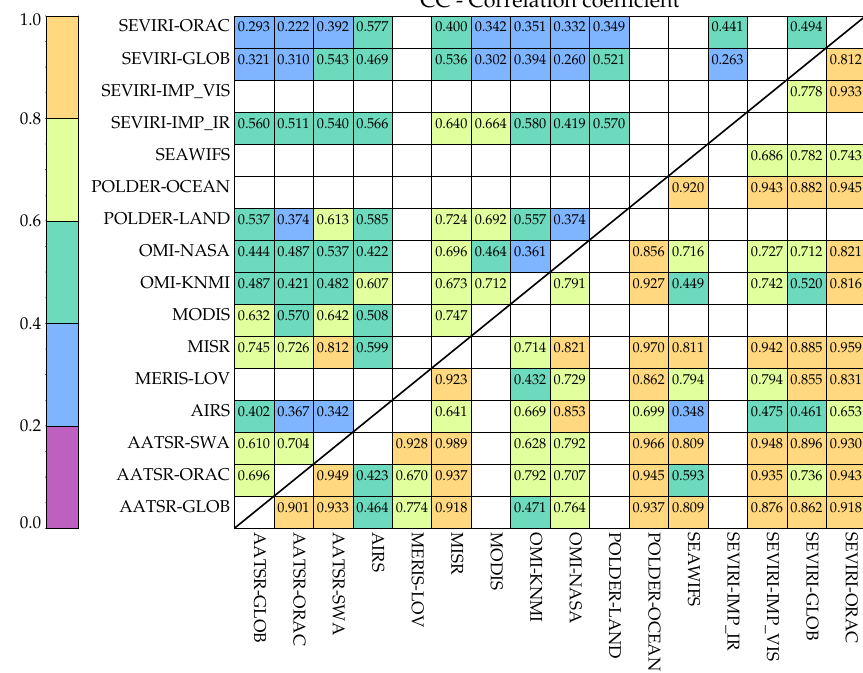
Fig. 8. Correlation coefficient obtained with the comparison of datasets vs. datasets. Values above the diagonal are for data over land, below the diagonal are over ocean.